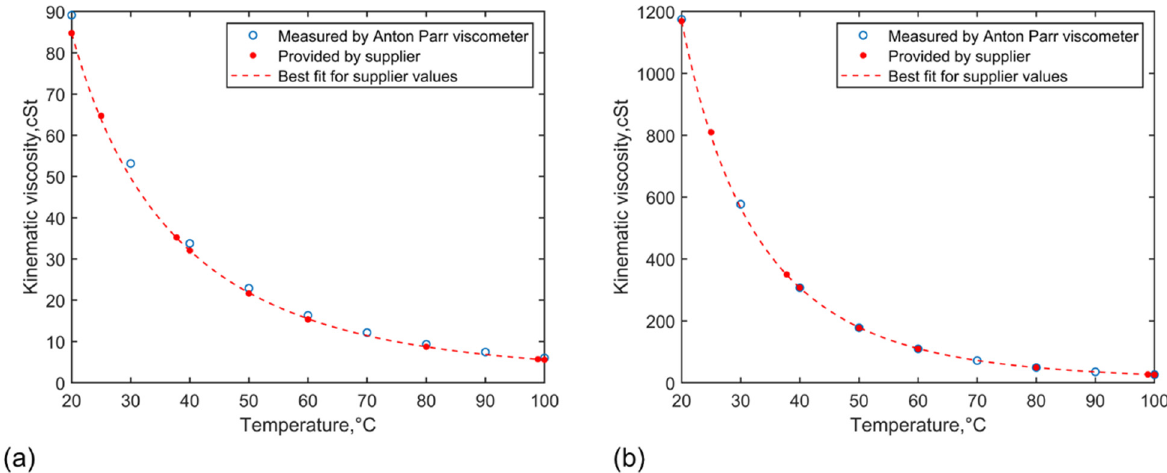
Figure 6. Results of the kinematic viscosity measured by the Anton Parr viscometer plotted against temperature, compared with the values provided by the viscosity standard supplier for ( a ) Paragon N35 and ( b ) Paragon N350.